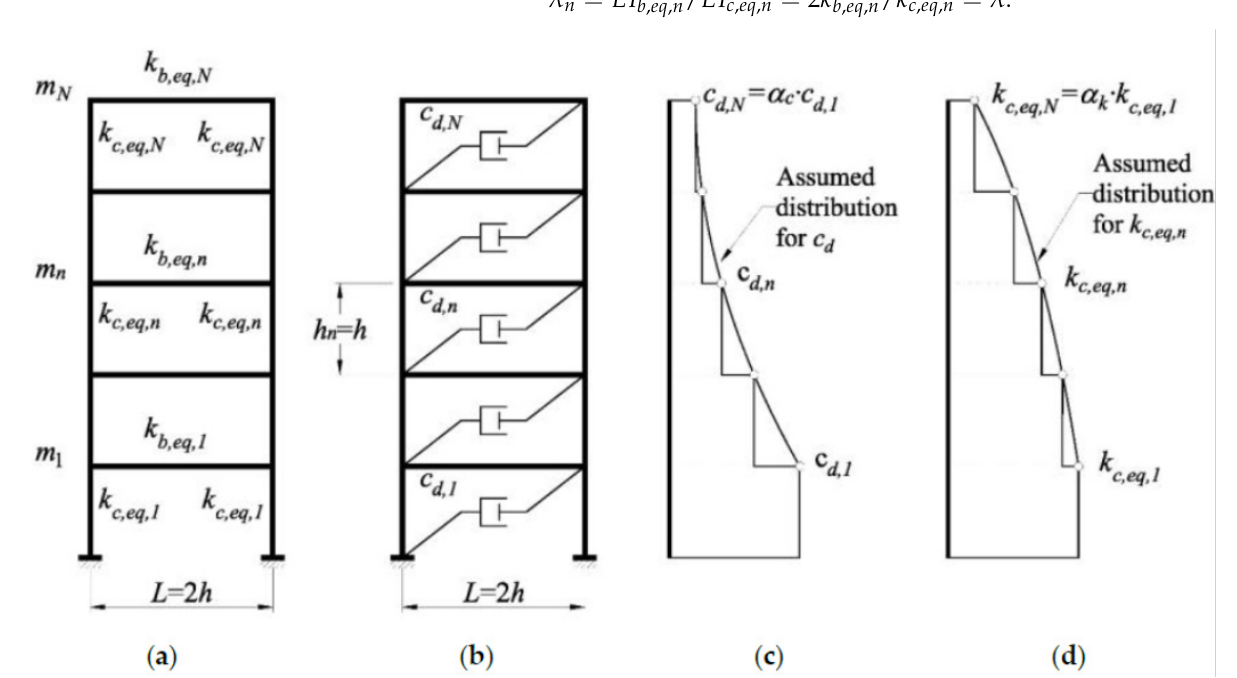
Figure 1. Parametric definition of MDOF systems: ( a ) frame-type system included in the study; ( b ) linear added damping system; ( c ) damper coefficient distribution; ( d ) column stiffness